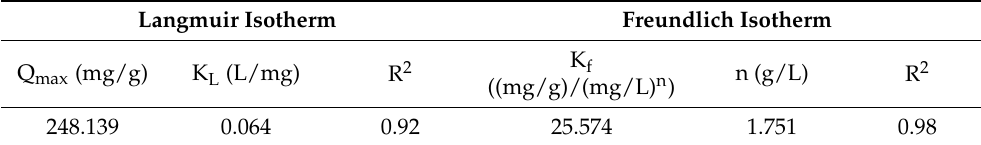
Table 2. The Langmuir and Freundlich isotherm constants of Co@AC to atrazine. Langmuir Isotherm